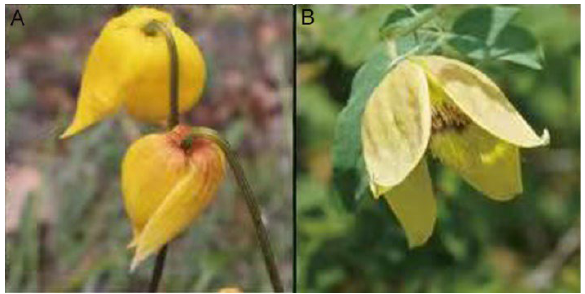
Figure 1. The flower of Clematis tangutica (Maxim.) Korsh. ( A ) G type ( B ) N type.